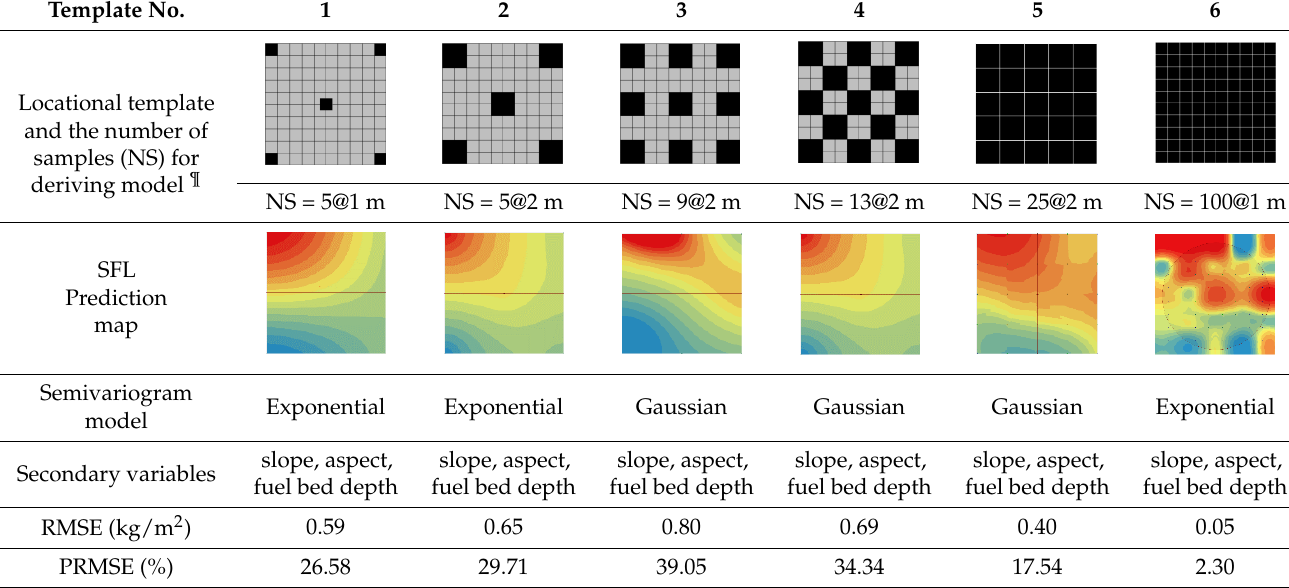
Table 6. A comparison of surface fuel load mapping using different numbers of samples within a spatial scale of a 10-m size plot. Template No.